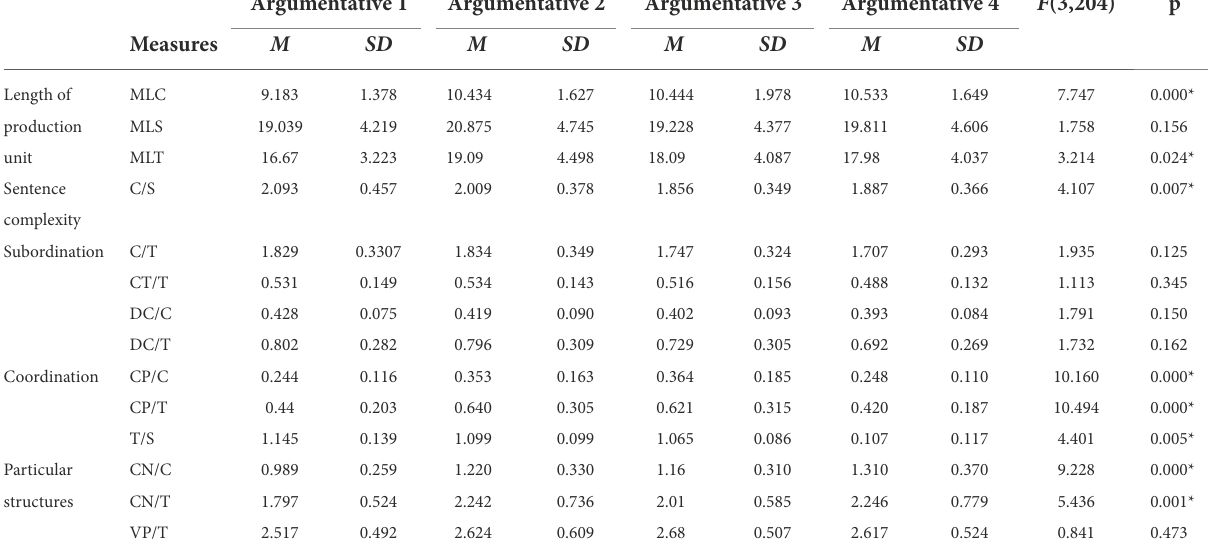
TABLE 3 The effect of time on the syntactic complexity of argumentative compositions.